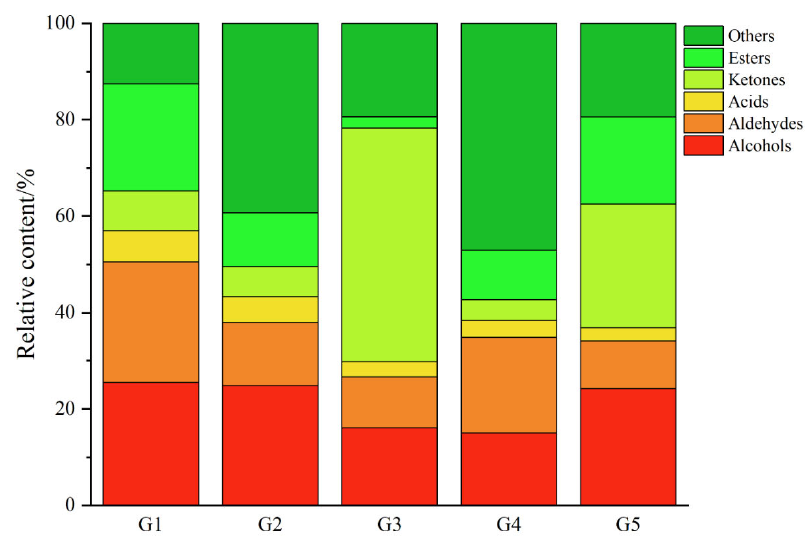
Figure 4. Relative content of various VFCs in pickled BLS with different salt concentrations.